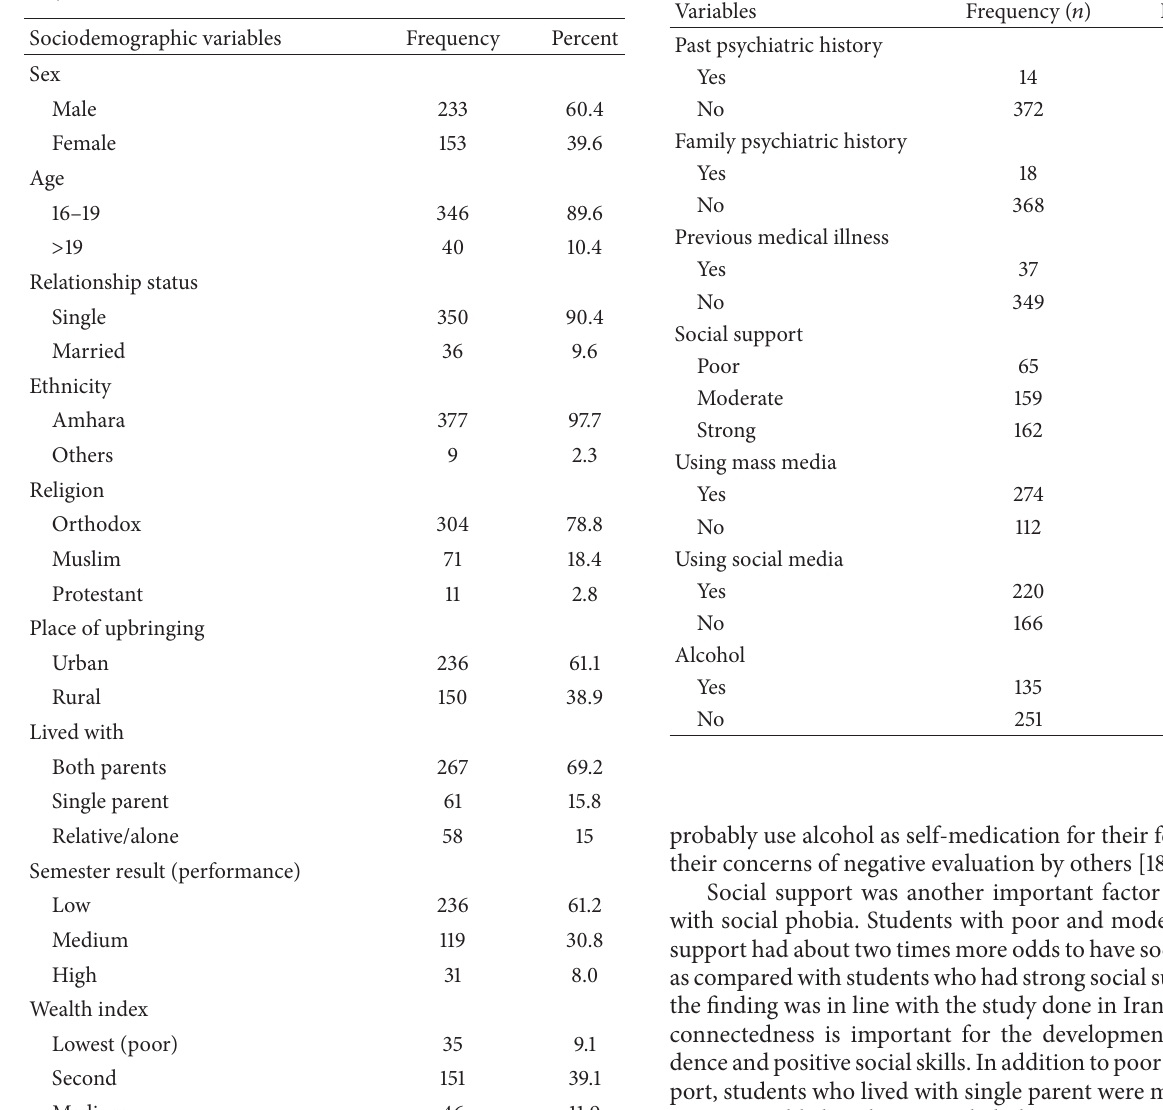
Table 2: Clinical conditions of respondents ( 𝑛 = 386